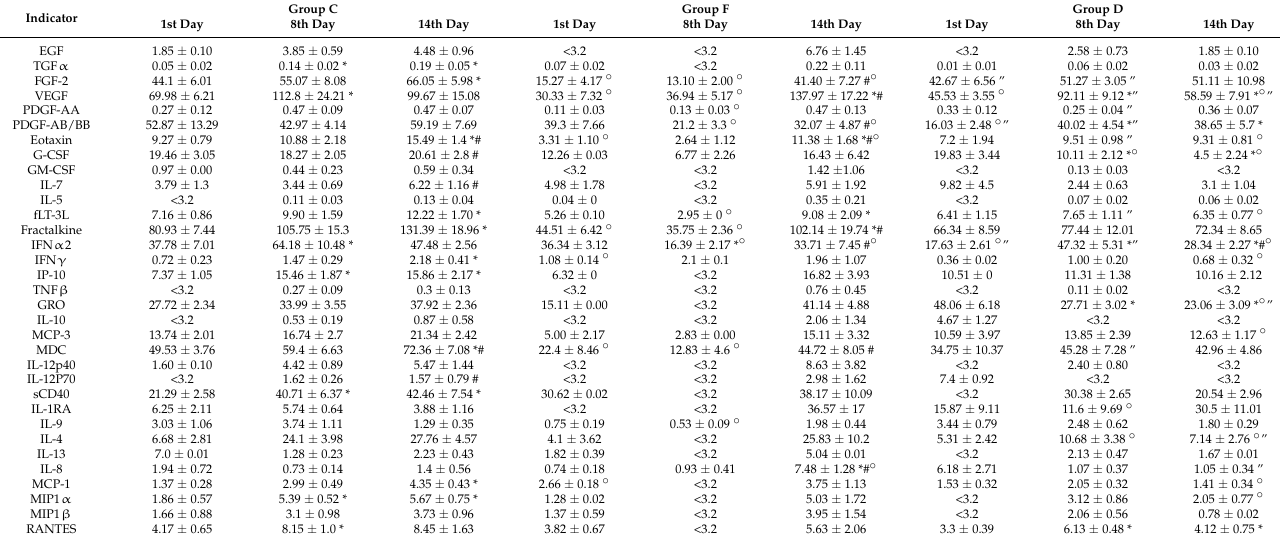
Table 2. Cytokine level changes (pkg/mL) in leukoconcentrates of immunodeficient rats under the aronia extracts’ action. * ( p < 0.05)—differences reliability in animal groups compared to day 1 of the experiment; # ( p < 0.05)—differences reliability in animal groups compared to day 8; ◦ ( p < 0.05)—differences reliability between animal groups compared to the control group; “ ( p < 0.05)—differences reliability between animal groups compared to rats that received frozen aronia fruits.